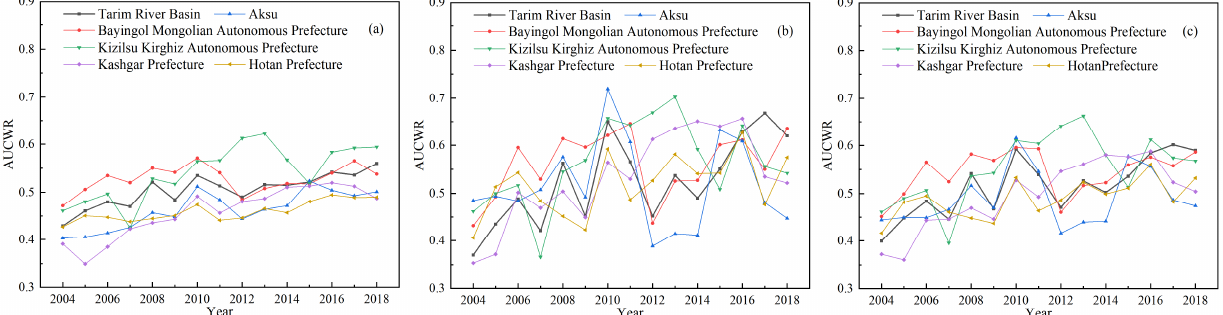
Figure 6. AUCWR and changes of various prefectures in the TRB. ( a , b ): calculation results of the harmony theory and the comprehensive co-evolutionary model method. ( c ): average of the results calculated by the two methods.